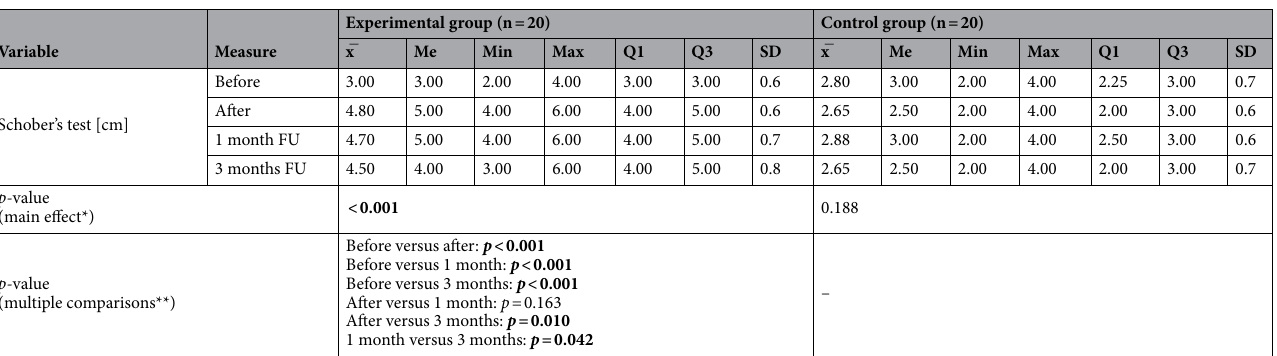
Table 4. The Schober’s test results in both groups. Significant values are in [bold]. n number of individuals, x ̅ , mean, Me median, Min minimum value, Max maximum value, Q1, lower quartile, Q3, upper quartile, SD standard deviation, FU follow-up. *Friedman’s ANOVA; **Dunn’s test.